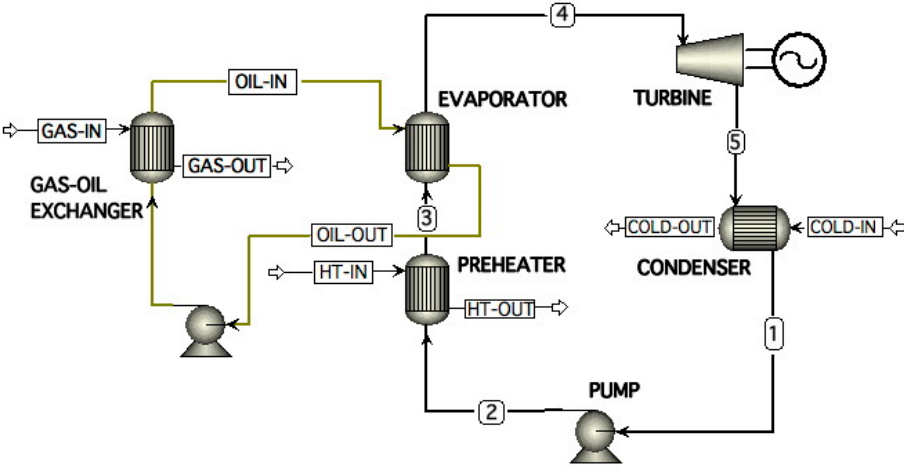
Figure 7. Simple ORC cycle with preheating from the engine HT cooling circuit.